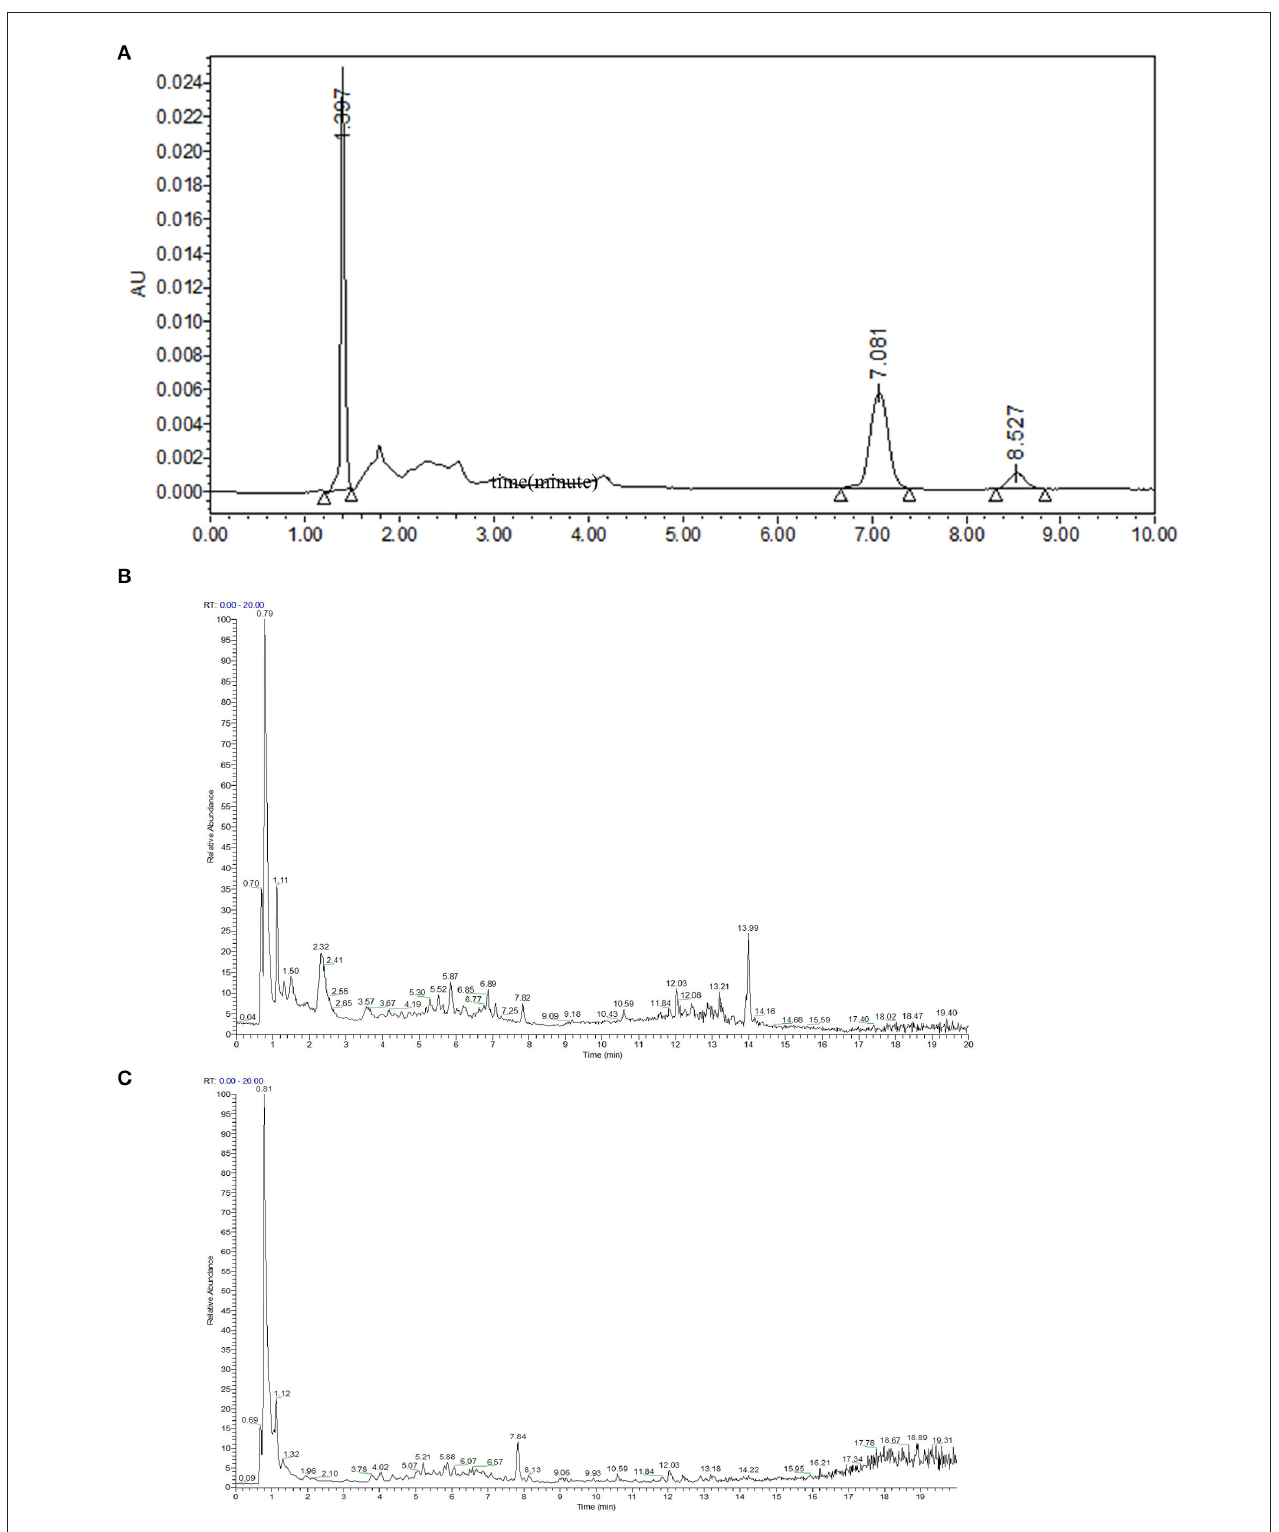
FIGURE 1 | Separation and identification of phytochemicals in PMEAT by HPLC-MS/MS. (A) The HPLC analysis chart. (B,C) The base peak chromatogram (BPC) for phytochemicals in A. tsao-ko methanol extract in the ESI + (B) and ESI– (C) modes.